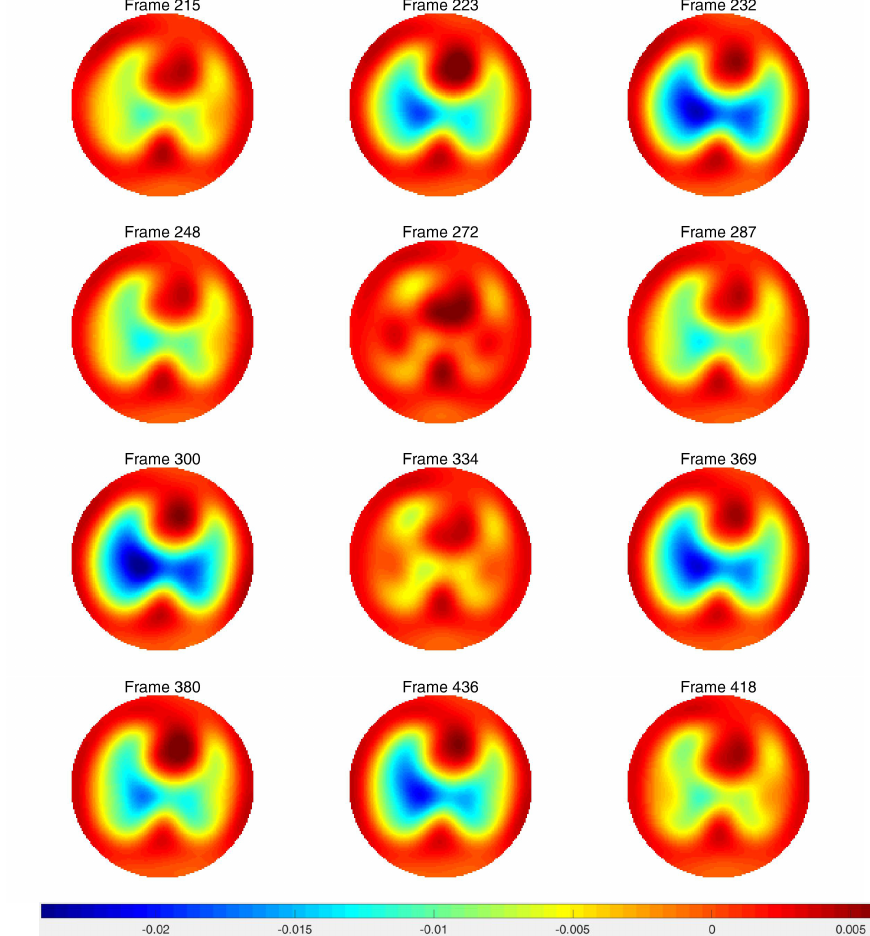
Figure 15. Difference images of ventilation data with modeling the domain to be a circle. A spatial prior is added. Frame 200 is used for the reference image. The truncation radius is